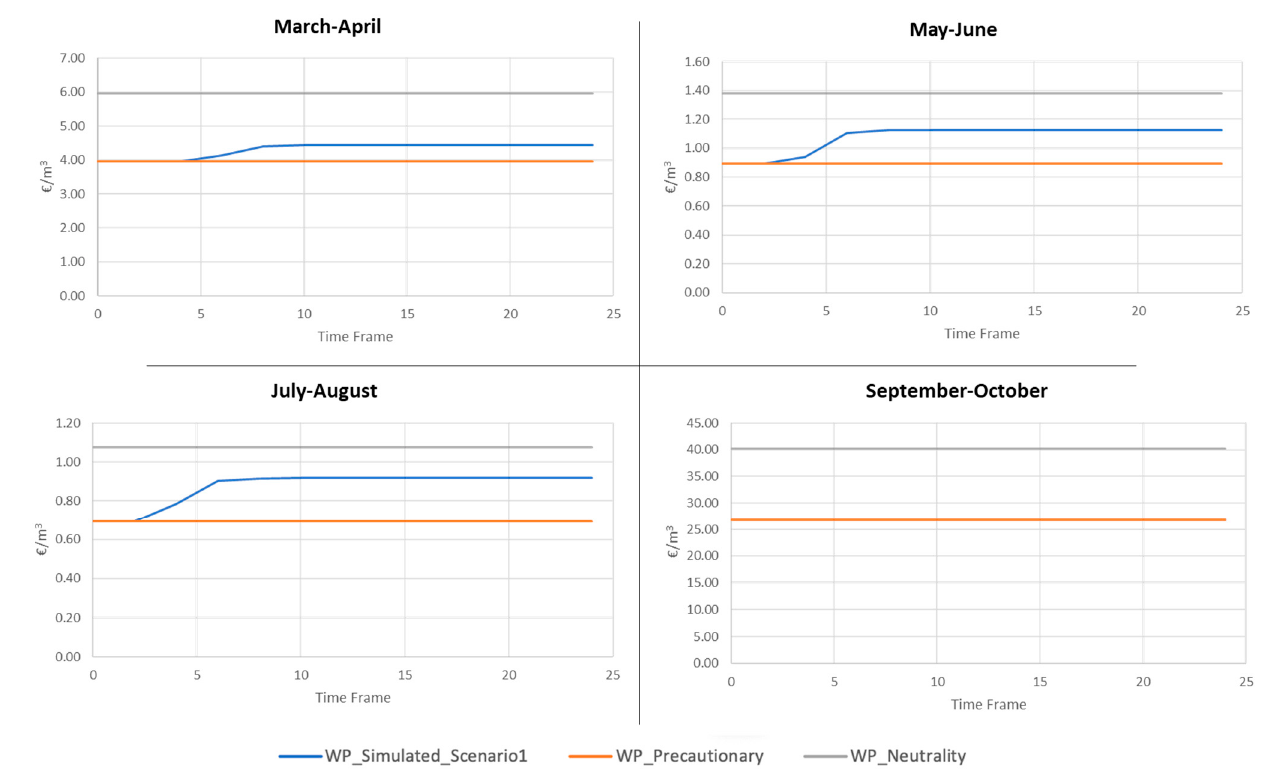
Figure 11. WP if no opportunity costs are